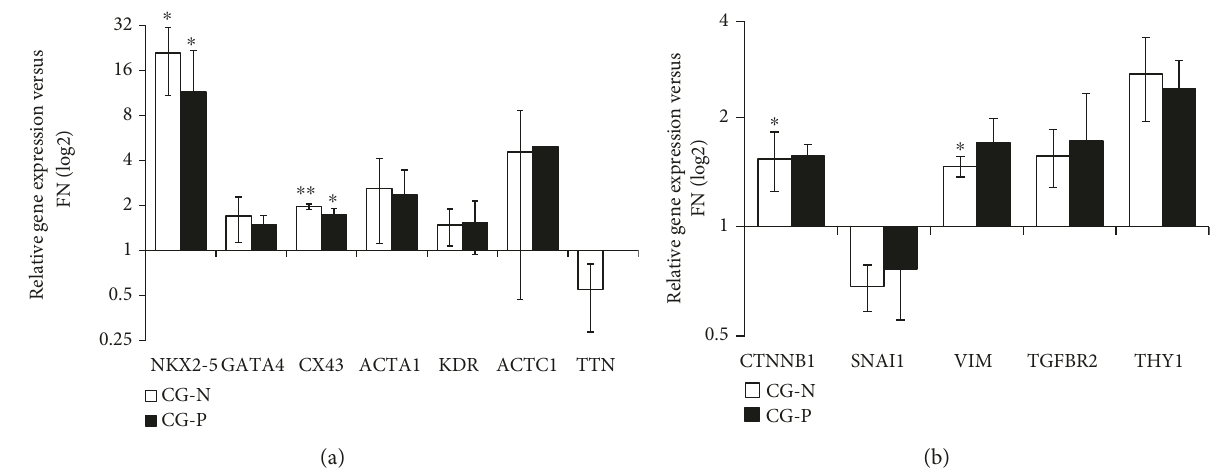
Figure 1: Relative gene expression levels of CDCs grown on normal (CG-N) and pathological cardiogel (CG-P). Bar graphs showing gene expression change in a panel of cardiac di ff erentiation and commitment (a) and mesenchymal (b) genes. Both CG-N and CG-P CDCs displayed signi fi cantly higher expression levels of the cardiac-speci fi c genes NKX2-5 and CX43 (a) compared to CDCs grown on fi bronectin used as the control. Only CTNNB (beta catenin) and VIM (b) were signi fi cantly upregulated in CG-N and CG-P CDCs, respectively, compared to the control ( n = 3 ). CG-N: normal cardiogel; CG-P: pathological cardiogel; ACTC1: cardiac muscle actin alpha; TTN: titin. ∗∗ p < 0 01 , ∗ p < 0 05 .